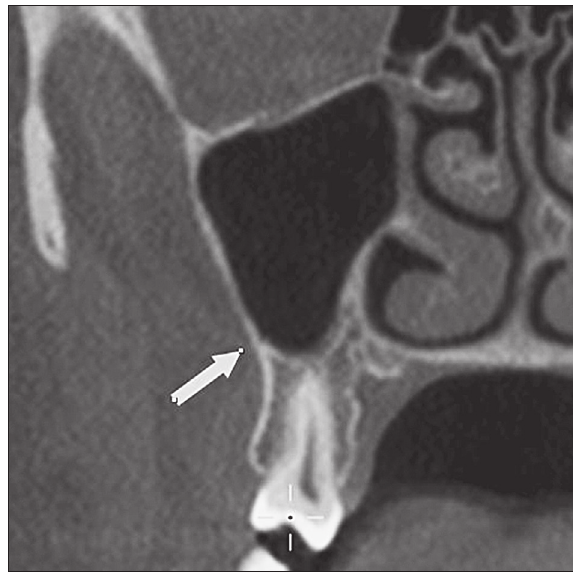
Figure 2 - Coronal view of the maxillary sinus reveals the intraosseous artery (arrow).